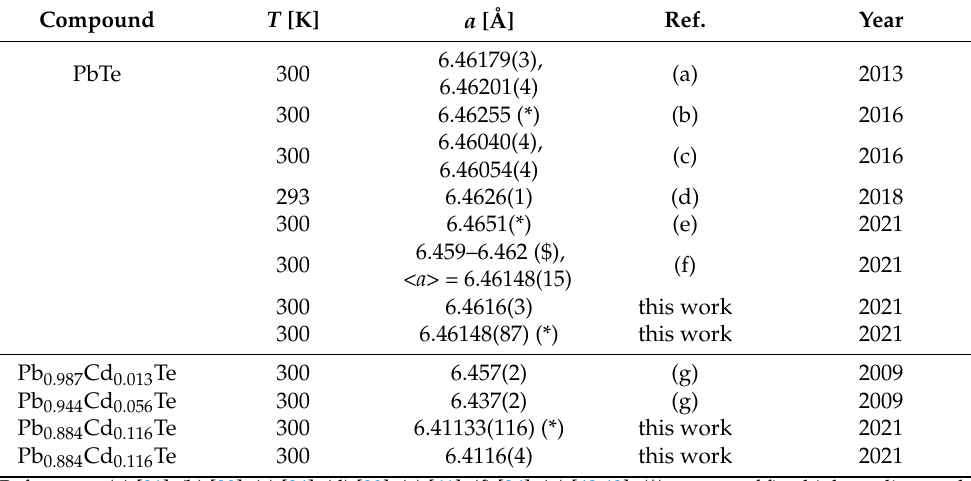
Table 7. Present and selected recently reported values of the experimental lattice parameter, a , at room temperature for PbTe and Pb 1 − x Cd x Te ( x = 0.013, 0.056, 0.116). For complete numerical data of a ( T ) of this work, see Tables A1 and A2 (Appendix B). Compound T